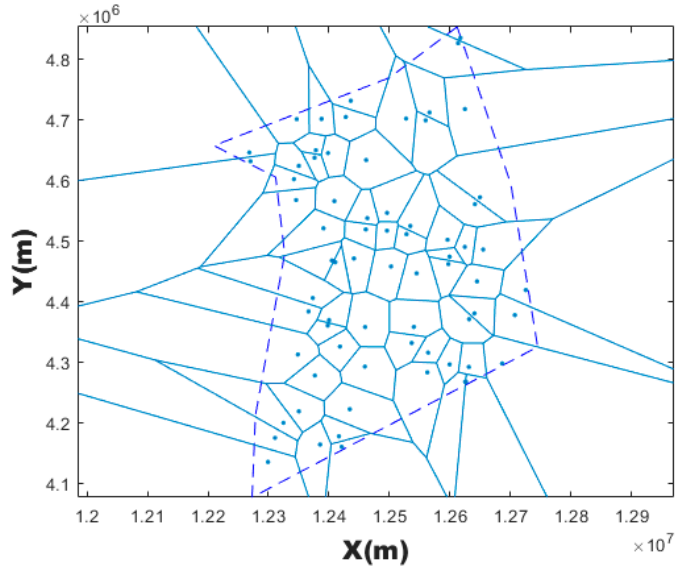
Figure 3. Random generating seeds.